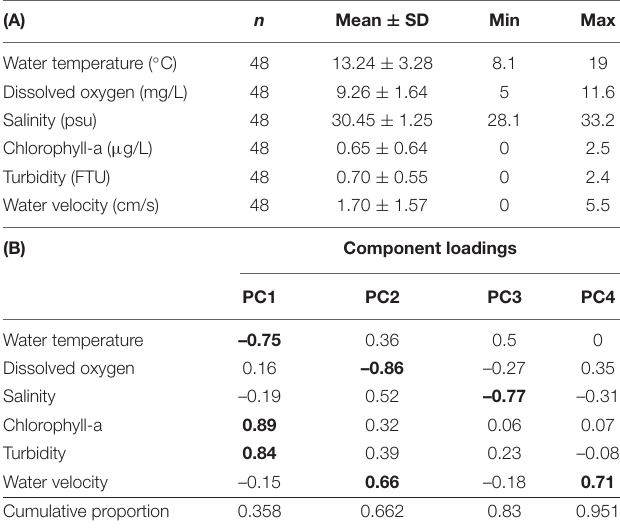
TABLE 1 | Summary of the principal component analysis using the environmental